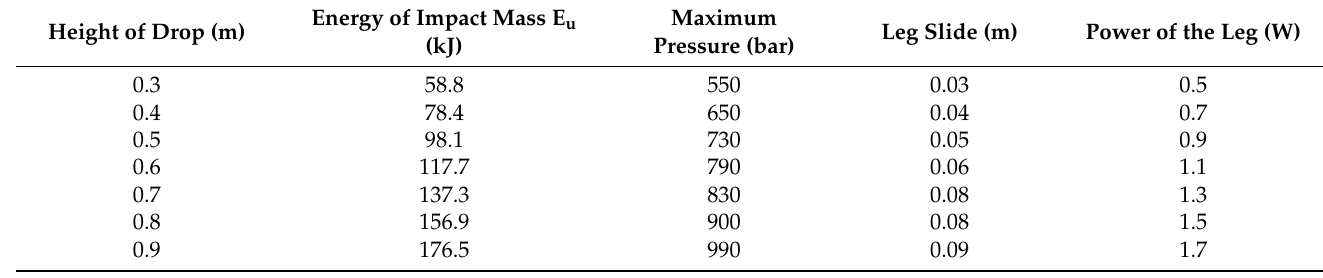
Table 2. Power occurring in the hydraulic leg during dynamic loading.